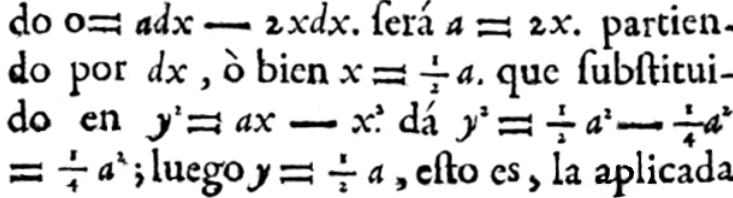
Figure 4. Maximum and minimum problem in a circumference. Source: Padilla y Arcos [54].